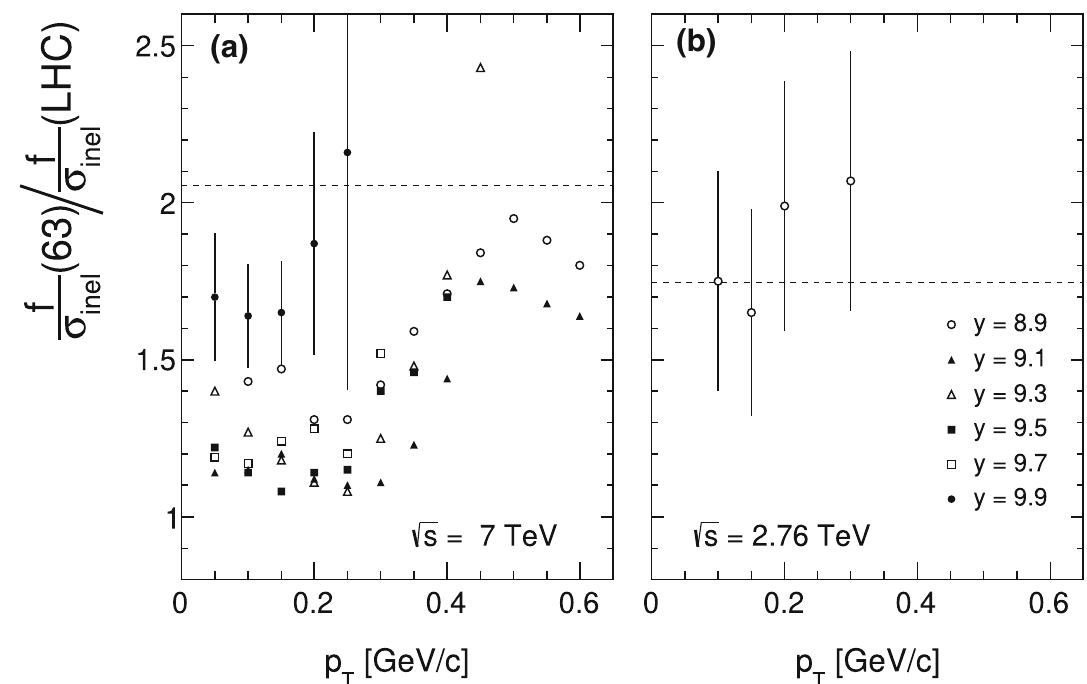
√ Fig. 95 Ratio of invariant cross sections f /σ inel between s = 63 GeV and 7 TeV (panel a ) and 2.76 TeV (panel b ) as a function of p T at constant rapidity. The ratios of the corresponding total inelastic cross sections R σ are indicated as broken lines